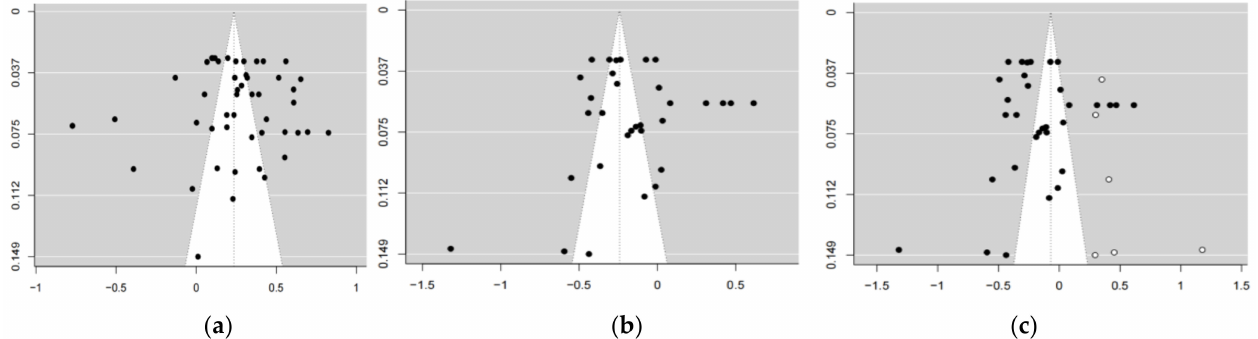
Figure 2. Funnel plots. ( a ) Funnel plot of mindfulness and cognitive reappraisal; ( b ) funnel plot of mindfulness and expressive suppression; ( c ) funnel plot of mindfulness and expressive suppression after trim-fill corrected. Note: The vertical coordinate represents the standard error, the horizontal coordinate represents Fisher’s z value transformed by r , and the hollow dot in the right-most figure represents the effect size that needs to be supplemented after the trim-fill method is